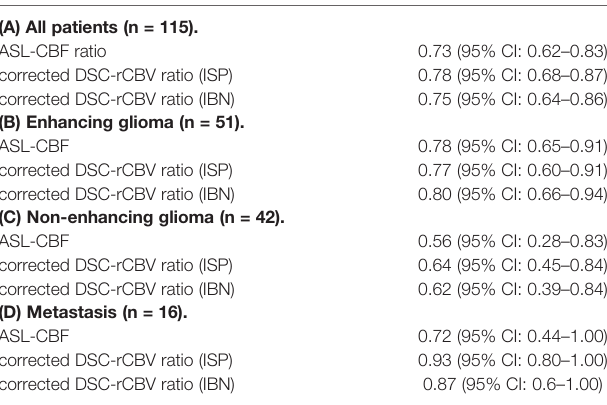
TABLE 4 | AUC values of diagnostic